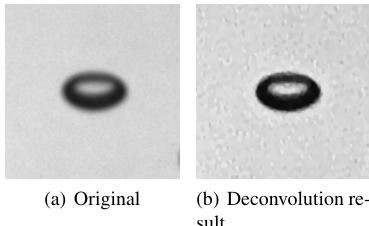
Figure 3: Noisy blurred image and its gradient sparsity deconvo- lution result.